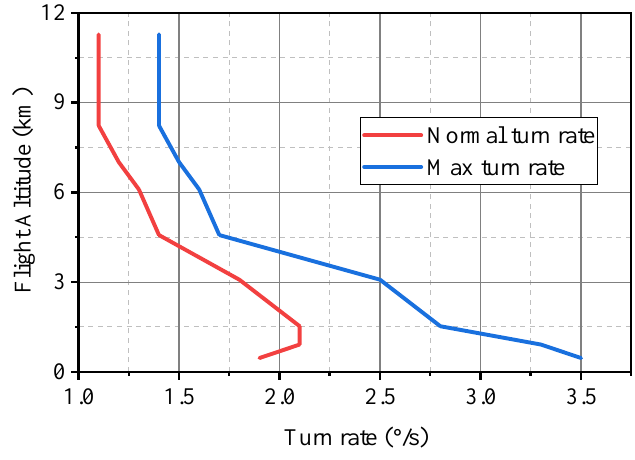
Figure 7. Turn rate for aircraft A320 in the ISA